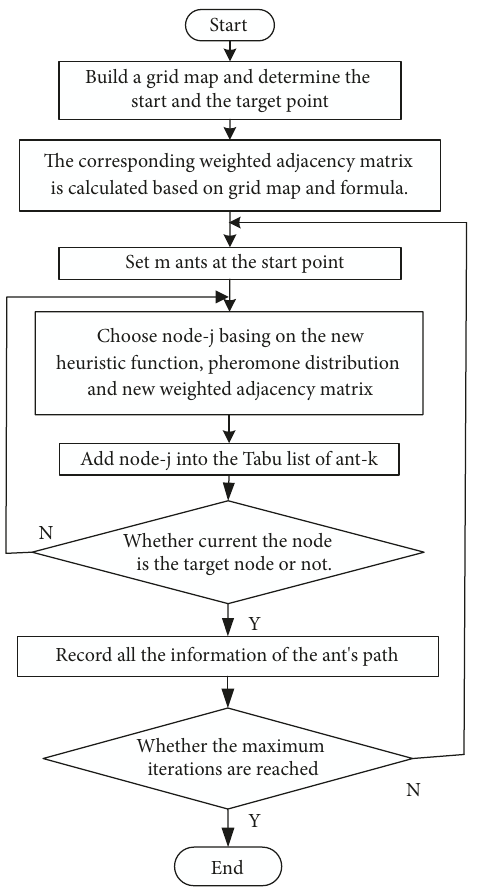
Figure 5: Algorithm flowchart.